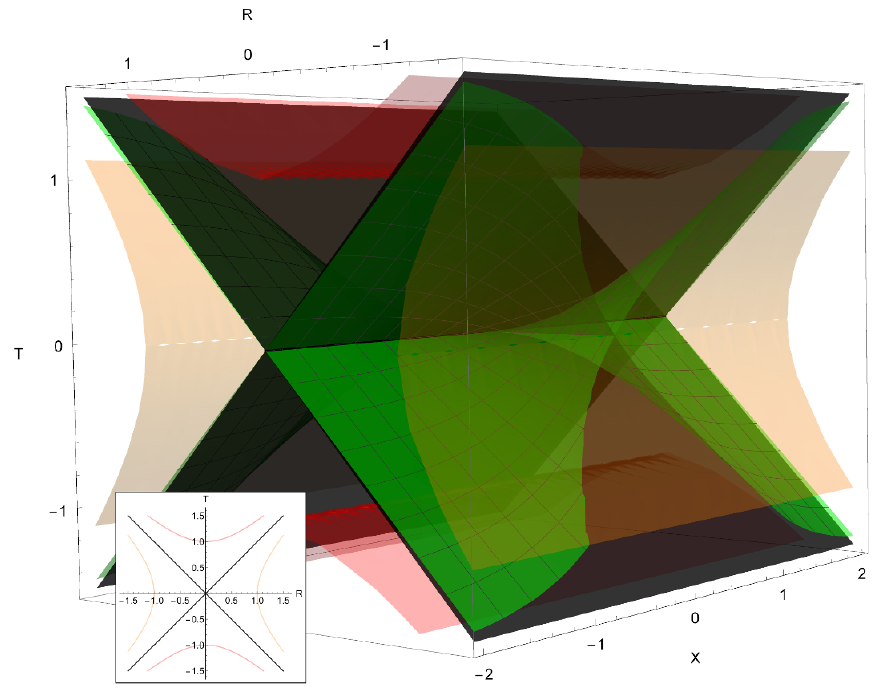
Figure 2 . Kruskal diagram of the bulk spacetime. The black diagonal sheets correspond to the location of the black hole’s horizon. The red surfaces show the location of the singularity, and the orange surfaces show the location of the boundary at z = 0. The green surface is the worldvolume of the bulk shockwaves along which the three regions of spacetime are glued together. A steady state region forms both for t > 0 and for t < 0. However, note that the physically relevant part of this spacetime for our investigation is assumed to be t (cid:21) 0